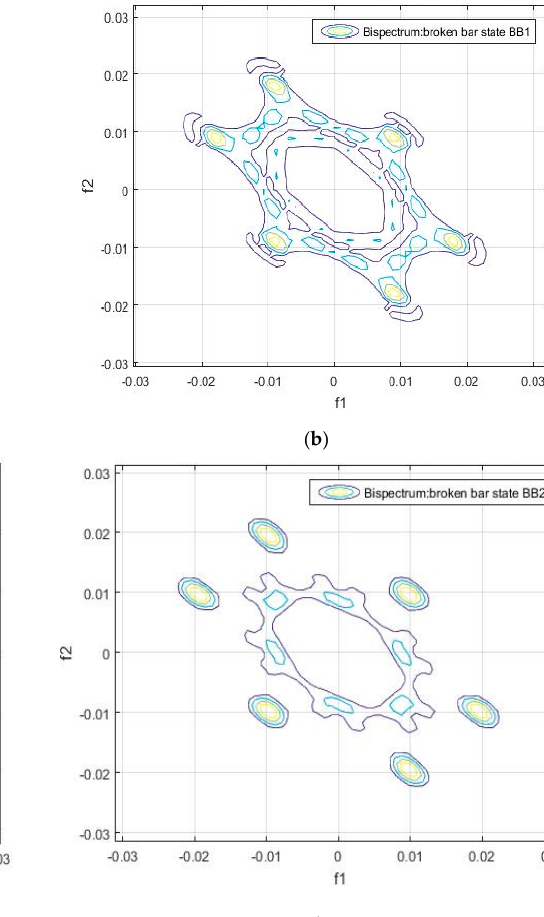
Figure 3. ( a ) Contour of bispectrum of the motor flux signal in healthy condition (sample 0, DMA position) ( b ) Contour of bispectrum of the motor flux signal in faulty condition (sample 0, DMA position).